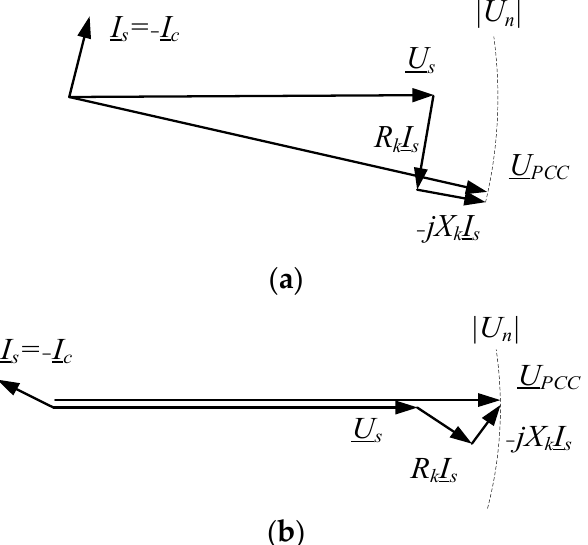
Figure 2. Voltage regulation: ( a ) using reactive power and ( b ) using active and reactive power with minimal current.